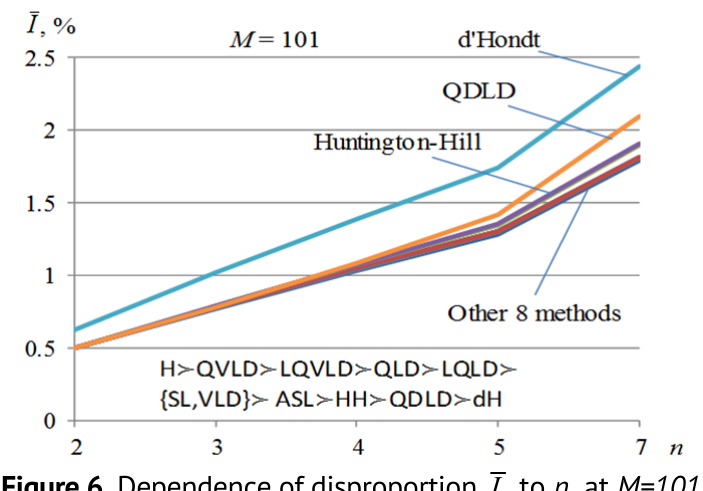
Figure 6. Dependence of disproportion I to n , at M=101 .